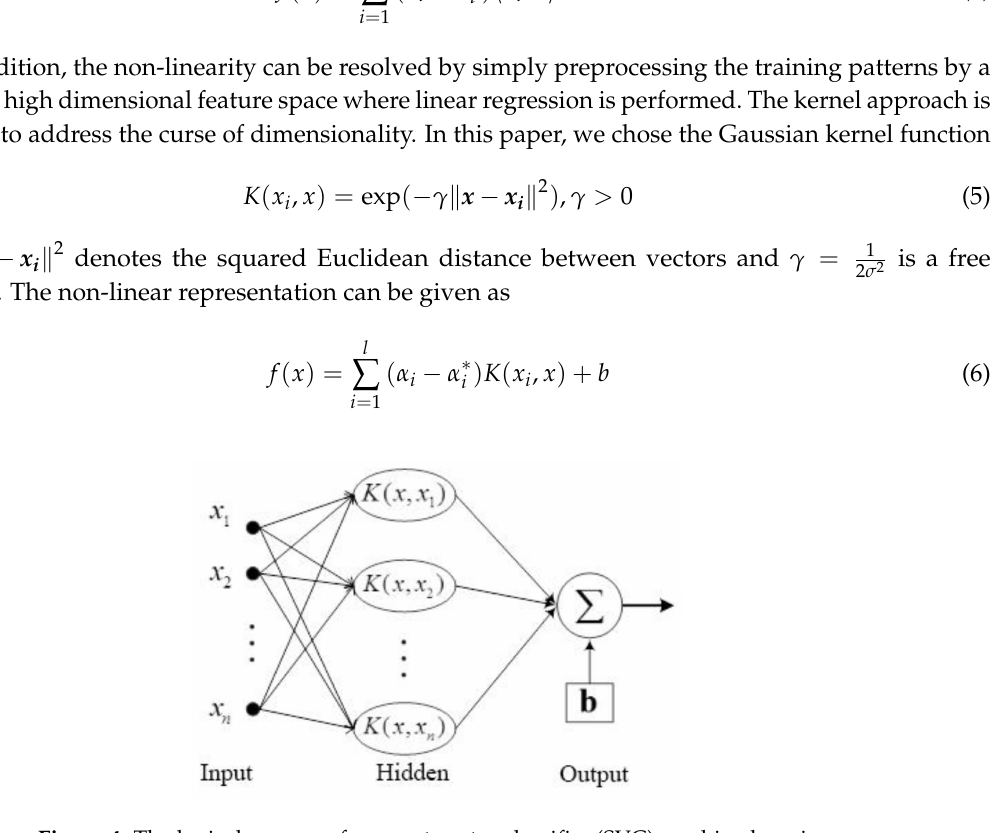
Figure 4. The logical process of support vector classifier (SVC) machine